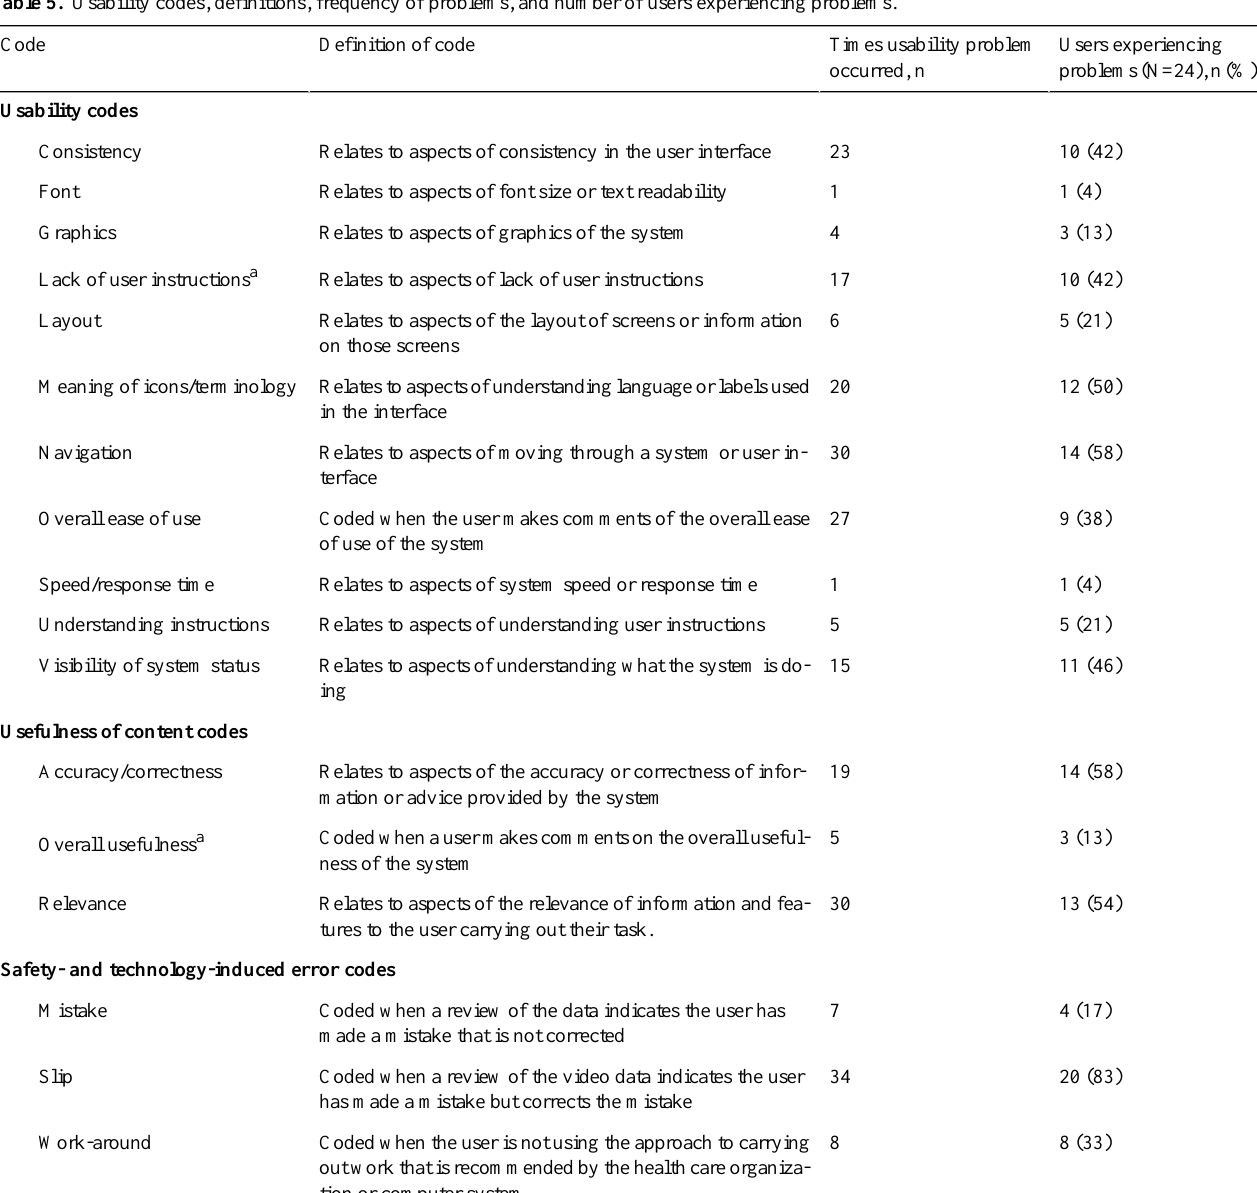
Table 5. Usability codes, definitions, frequency of problems, and number of users experiencing problems.